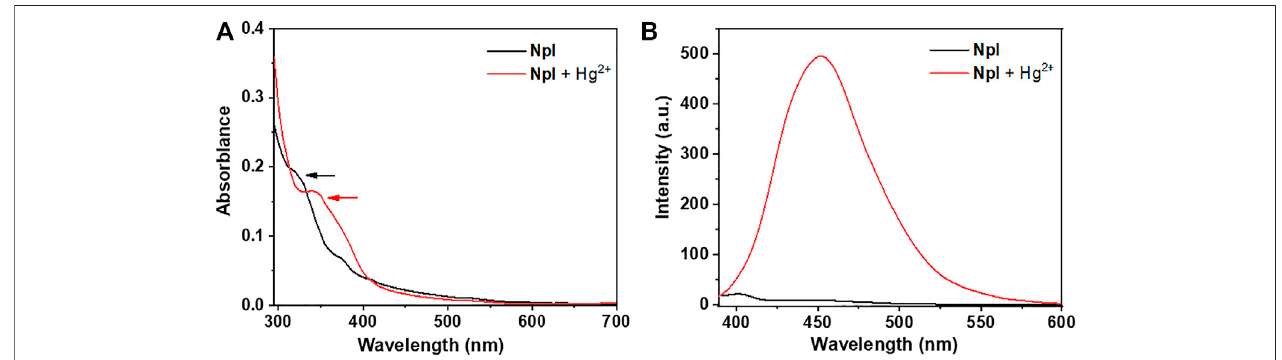
FIGURE1|(A) Absorptionspectraof NpI (blackline)and NpI +1.0equivHgCl 2 (redline)inPBSbuffersolutions. (B) Emissionspectraof NpI (blackline)andinthe presence of 1.0 equiv HgCl 2 (red line) in PBS buffer